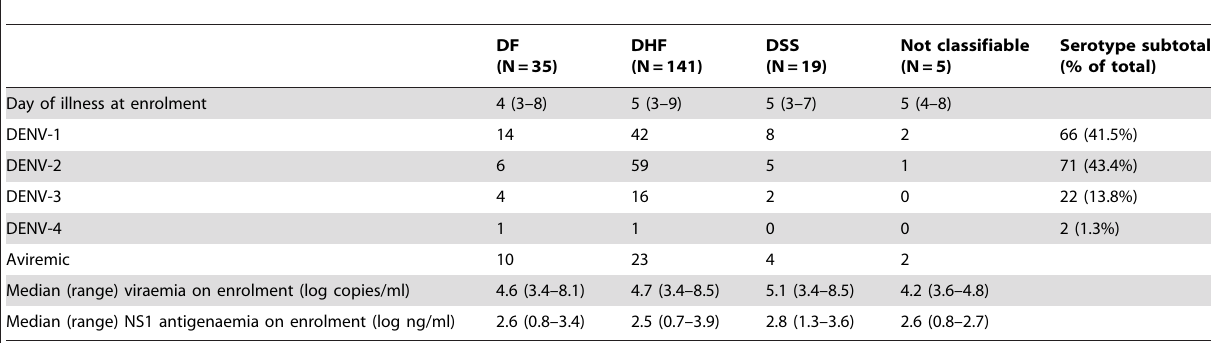
Table 5. Virological characteristics at enrolment in infants with